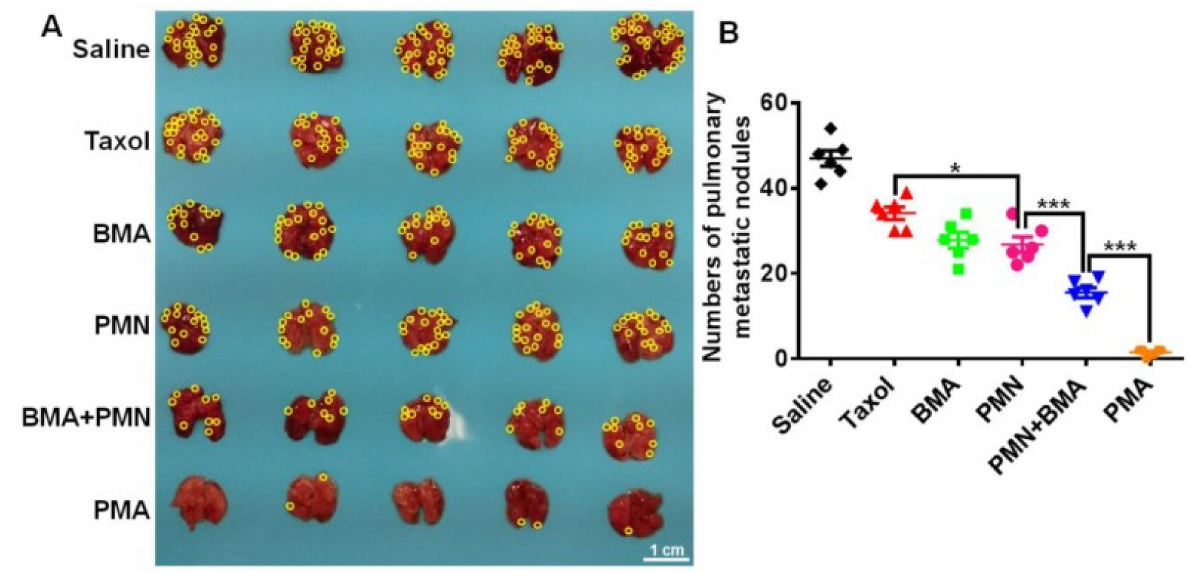
Figure 7. Anti-metastasis effect of different formulations in 4T1 tumor-bearing mice. ( A ) Images of the lungs at day 25. ( B ) Quantitative analysis of the pulmonary metastatic nodules at day 25. The yellow circles indicate metastatic nodules on the lungs. (Scale bar: 1 cm) Data are shown as mean ± SD ( n = 5). * p < 0.05 and *** p < 0.001